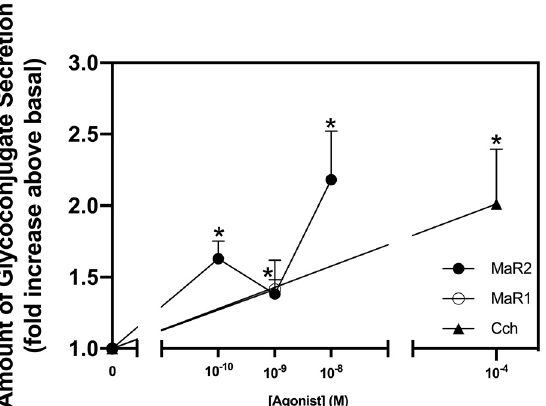
Figure 1. Maresin 2 (MaR2) stimulates glycoconjugate secretion. Rat conjunctival goblet cells were stimulated with either MaR2 (10 − 10 –10 − 8 M) Maresin 1 (MaR1, 10 − 8 M), or carbachol (Cch, 10 − 4 M) for 2 hr. High molecular weight glycoprotein secretion was measured. Data are mean ± SEM from six experiments. * shows significance above basal. SEM, standard error of the mean.